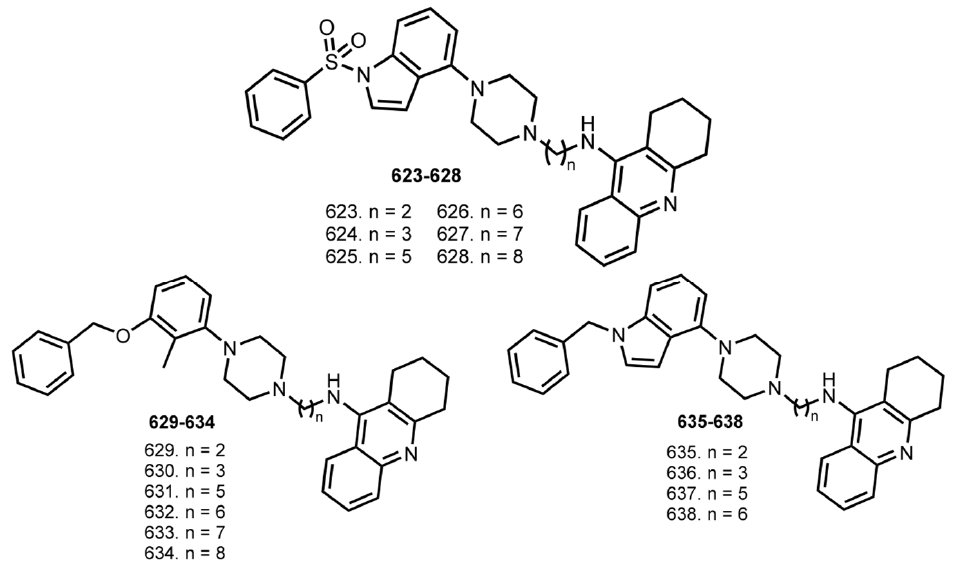
Figure 25. THA ‐ 1 ‐ (phenylsulfonyl) ‐ 4 ‐ (piperazin ‐ 1 ‐ yl) ‐ 1H ‐ indole hybrids 623 – 628 [100], THA– Figure 25. THA-1-(phenylsulfonyl)-4-(piperazin-1-yl)-1H-indole hybrids 623 – 628 [100], THA–5HT6- 5HT6 ‐ agonist hybrids 629 – 638 [101]. agonist hybrids 629 – 638